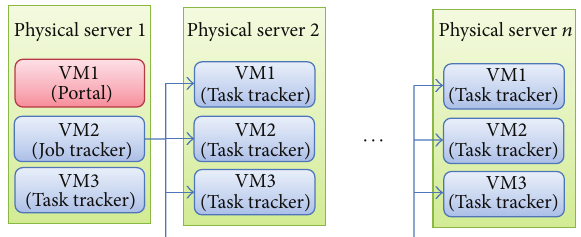
Figure 4: Cloud computing service based on virtualization technol-